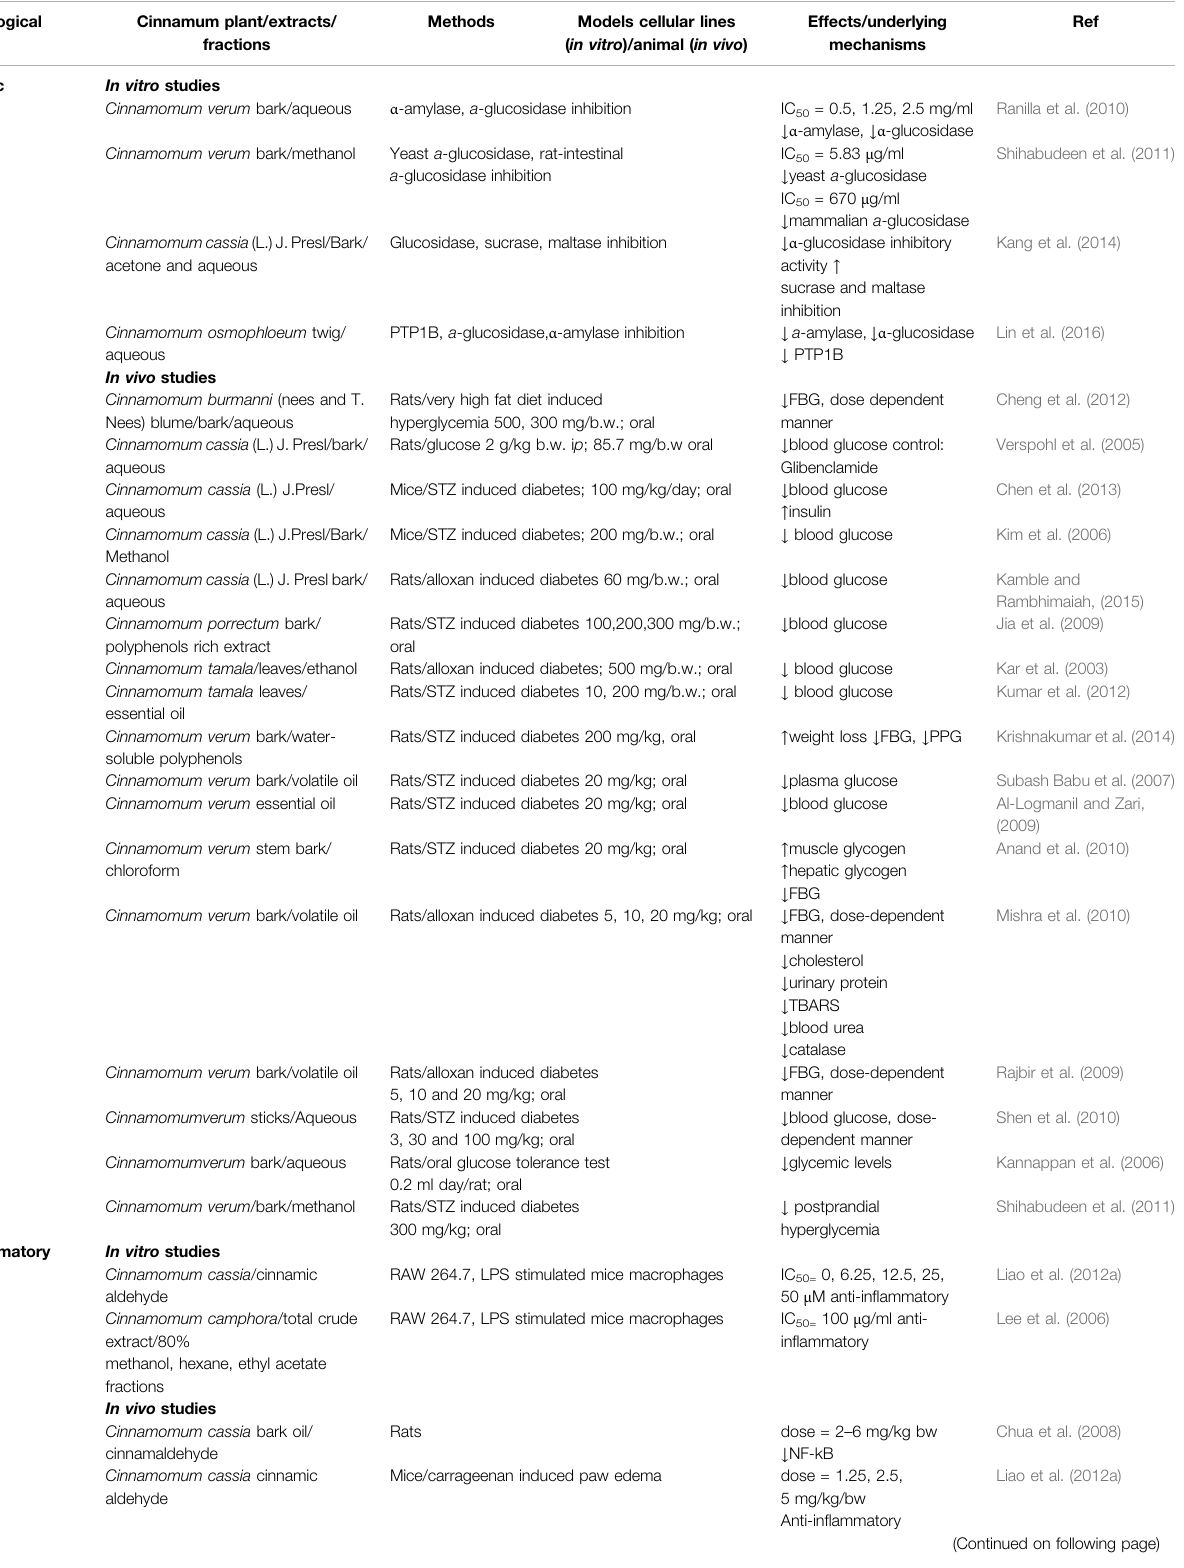
TABLE 2 | ( Continued ) Preclinical pharmacological activities of Cinnamomum